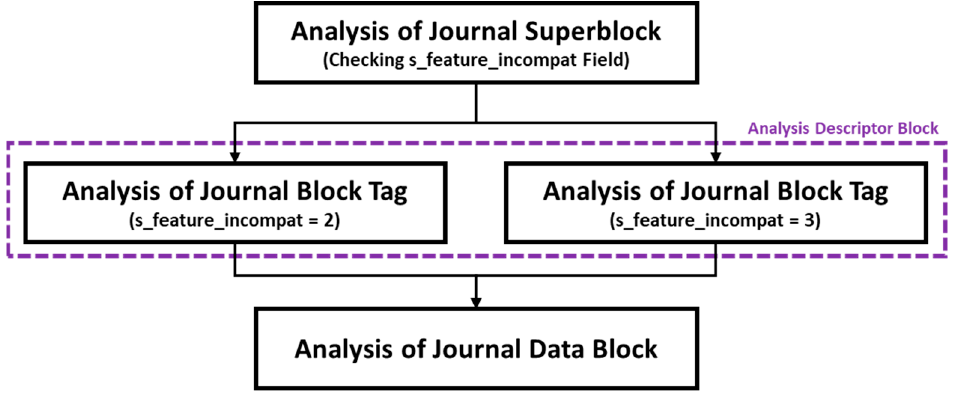
Figure 4. Ext4 journal-based file recovery module using TSK.